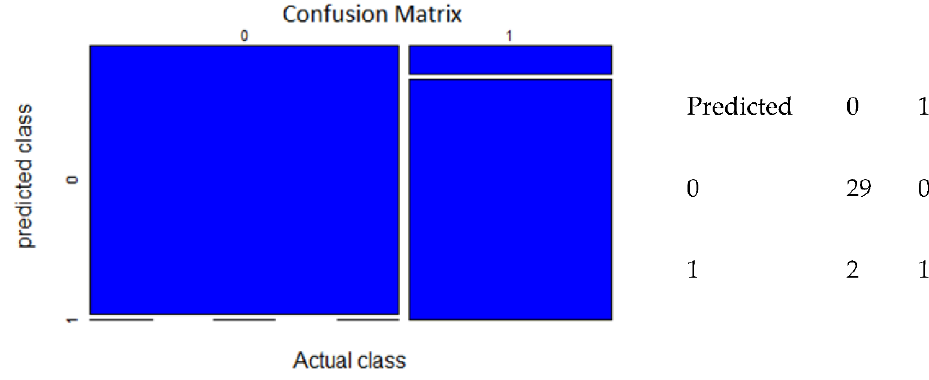
Figure 4. Confusion matrix of ANN model (predicted class vs. actual class).